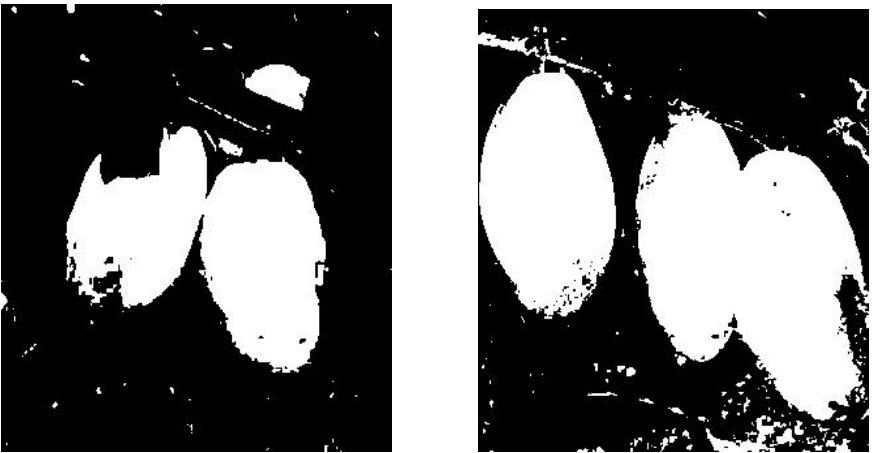
Figure 6. Segmented result based on differences in color